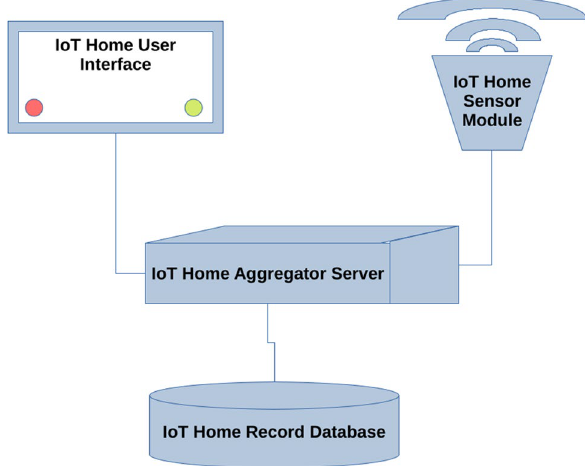
Fig. 9 Pictorial representation of the basic IoT home